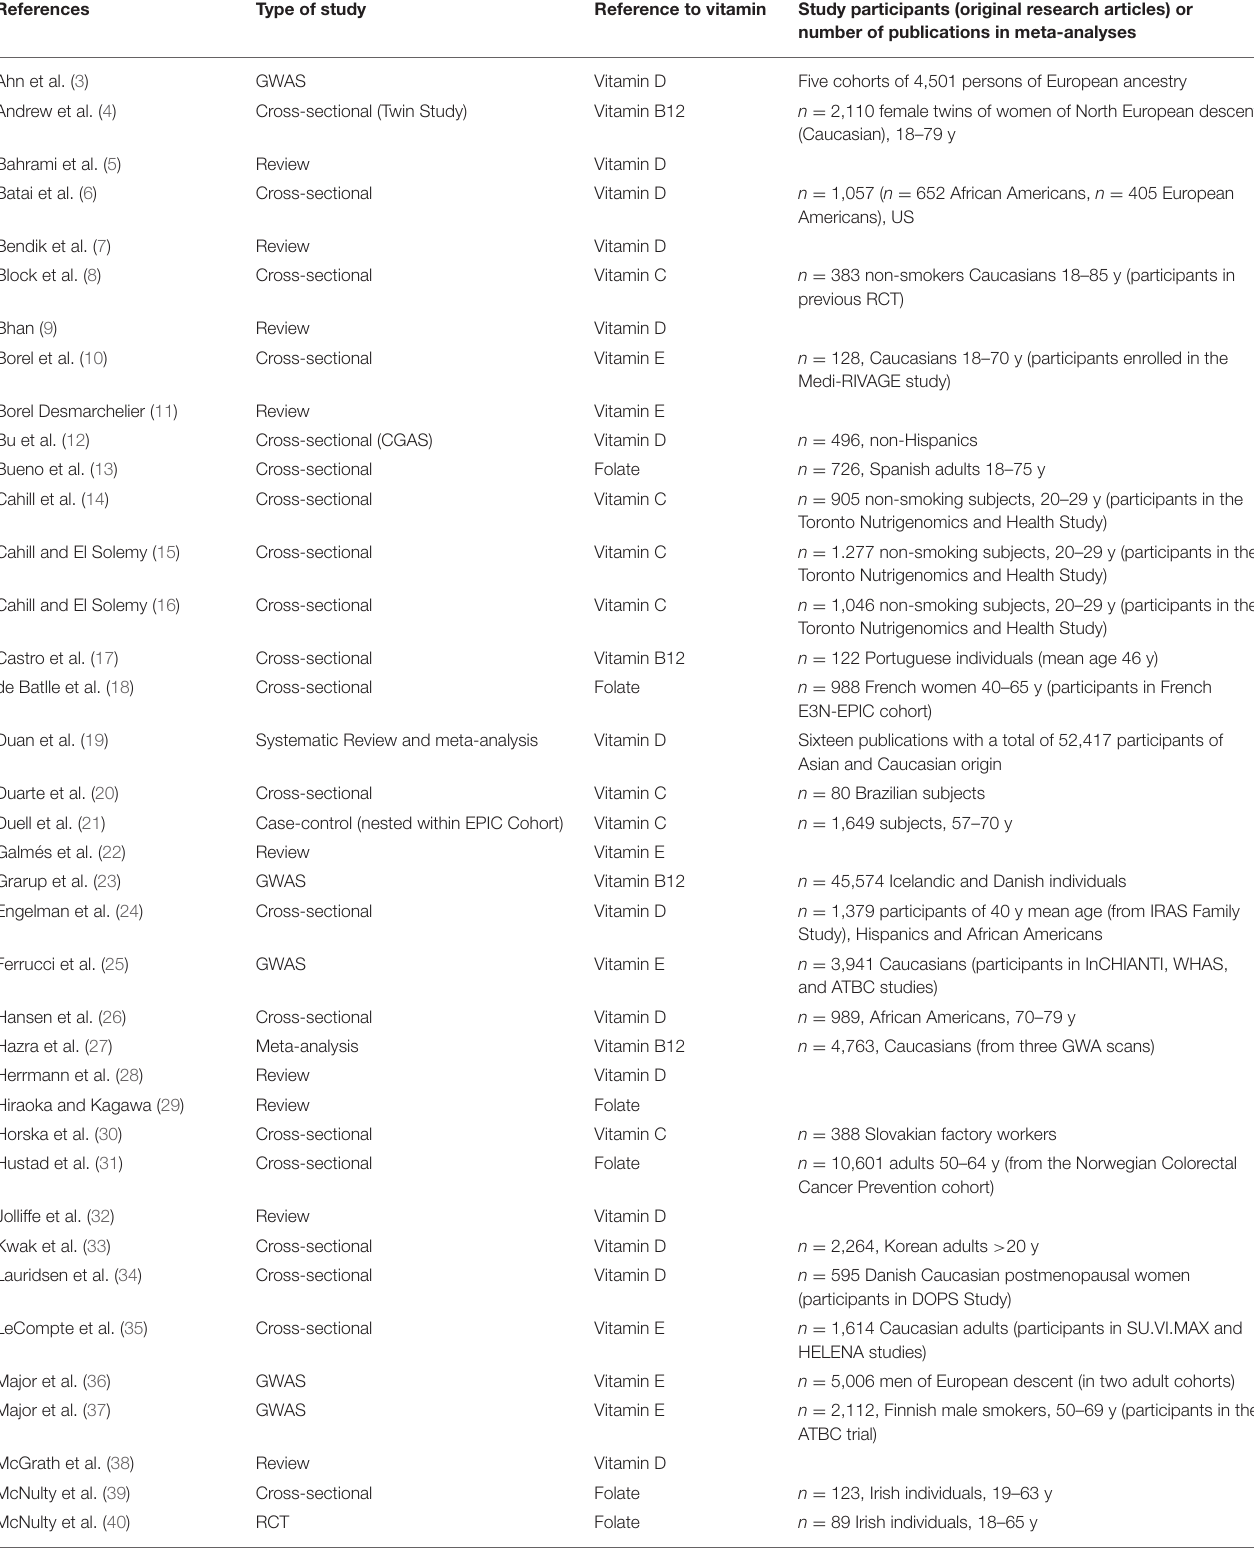
TABLE 1 | Characteristics of the publications included in the review ( n =